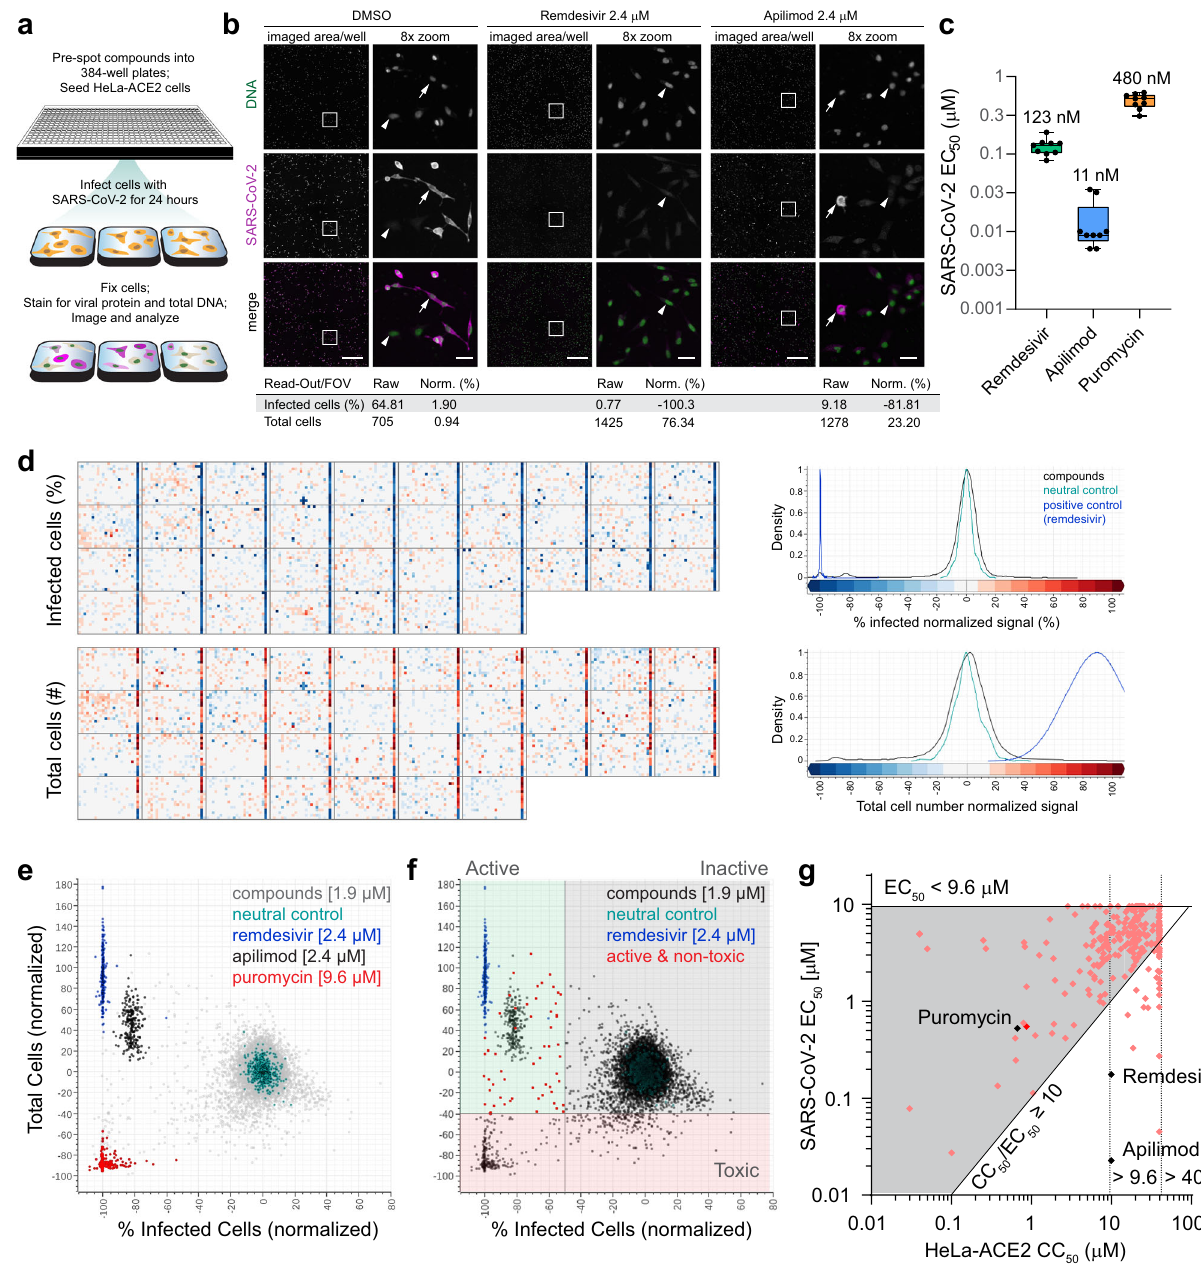
Apilimod 2.4 (cid:2) MRemdesivir 2.4 (cid:2) MDMSO